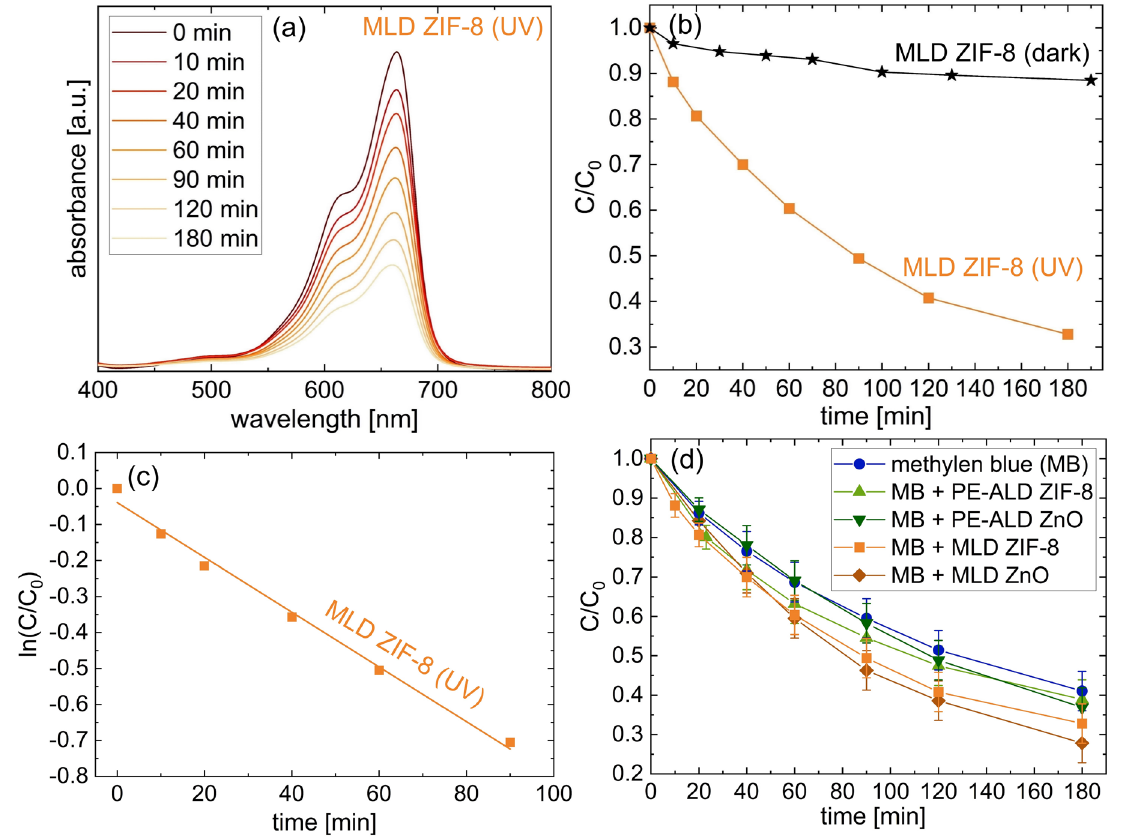
Figure 5. ( a ) UV-vis absorption spectra, ( b ) concentration change, and ( c ) pseudo-first-order kinetics curve of a 10 − 5 mol/L methylene blue (MB) solution in the presence of ZIF-8 under UV irradiation or while kept in a dark environment over time. ( d ) Concentration change of the MB solution when subjected to UV light, either on its own or in the presence of ZIF-8 or ZnO. “MLD ZIF-8” refers to ZIF-8 converted from ZnO thin films with 16% open porosity. “PE-ALD ZIF-8” refers to ZIF-8 converted from non-porous ZnO thin films, which were deposited via plasma-enhanced atomic layer deposition.